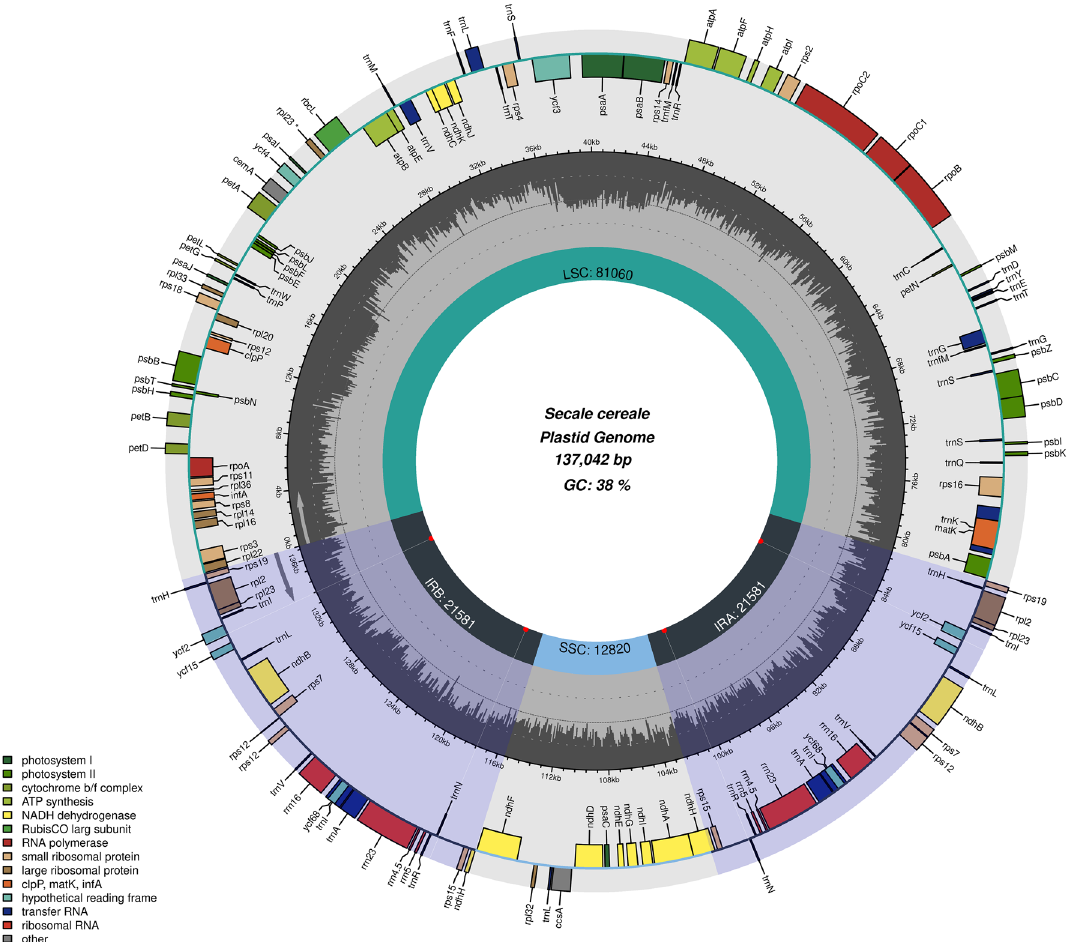
Figure 1. Map of the chloroplast genome of Secale cereale ssp. segetale . The genes inside and outside the circle are transcribed in the clockwise and counterclockwise directions, respectively. Genes belonging to different functional groups are shown in different colors. Tick lines indicate the extent of the inverted repeats (IRa and IRb) that separate the genomes into small single-copy (SSC) and large single-copy (LSC) regions. The innermost darker gray corresponds to GC-content while the lighter gray corresponds to AT